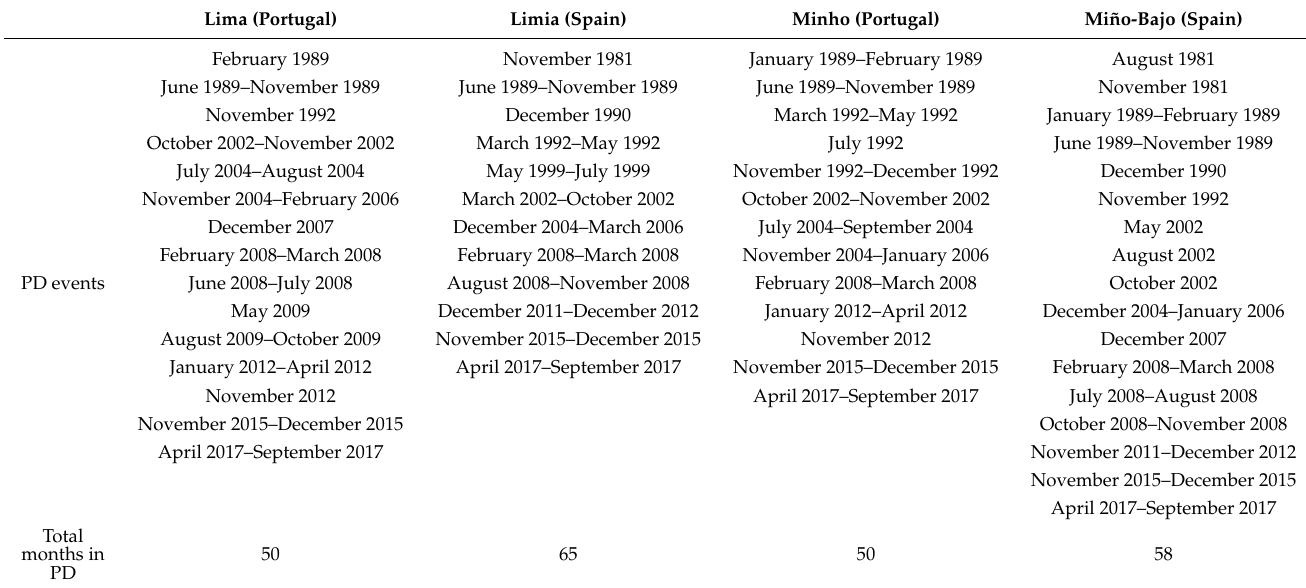
Table 1. Prolonged drought events in the Portuguese and Spanish parts of the Lima and Minho river basins (period October 1980 to September